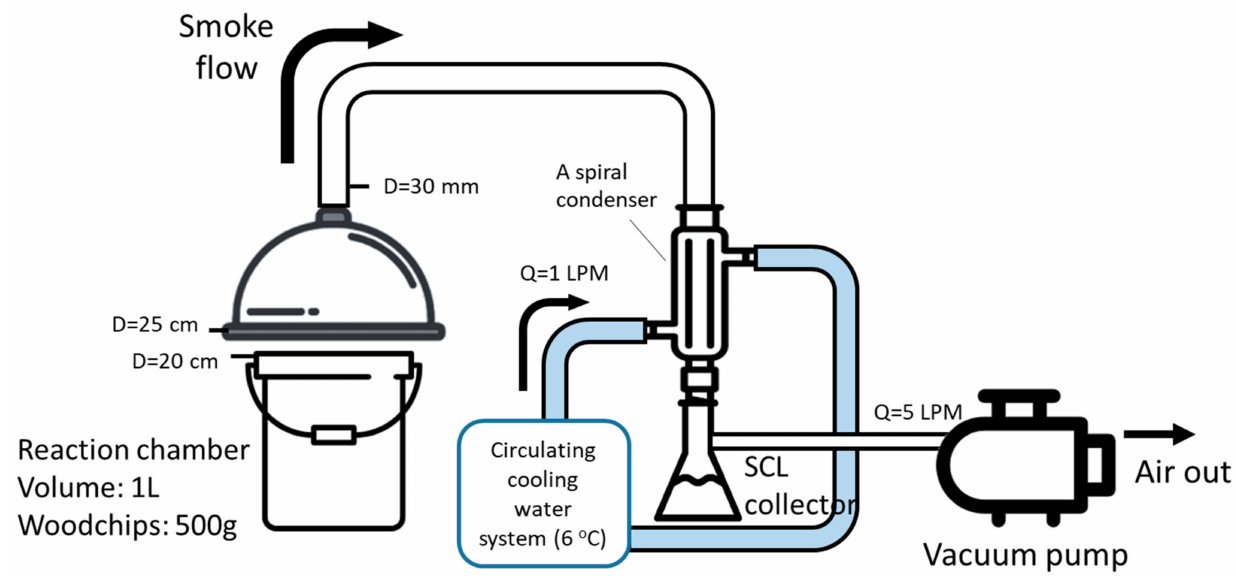
Figure 1. Design and operating conditions of the fruit tree smoldering